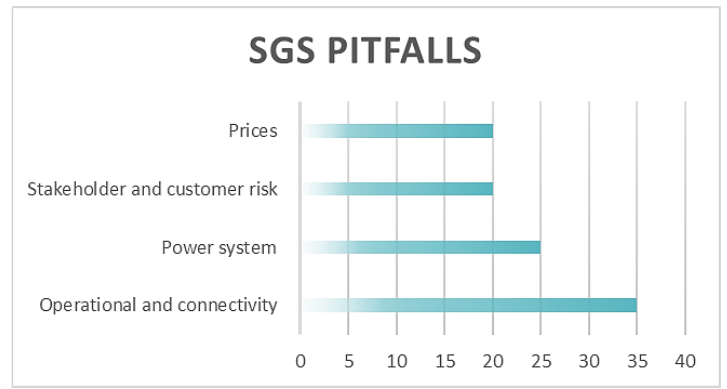
Figure 9. Pitfalls of the smart grid system.